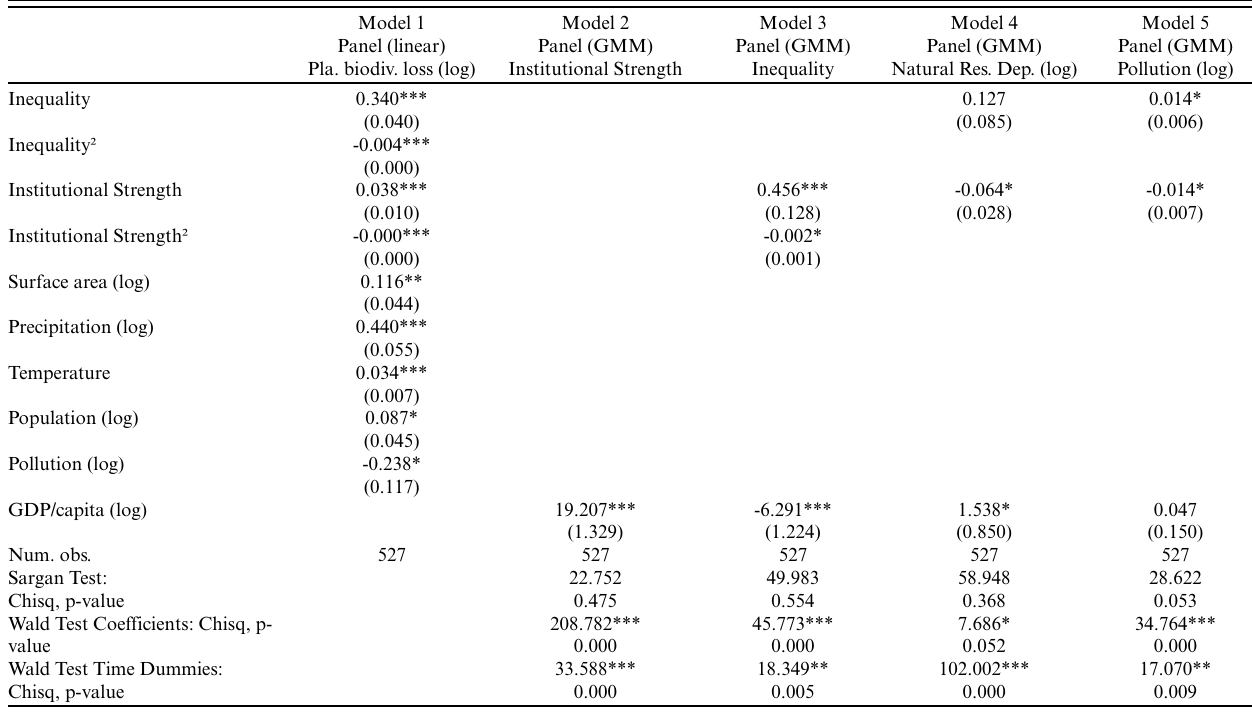
Table 3 . Model results for plant biodiversity loss (direct and indirect